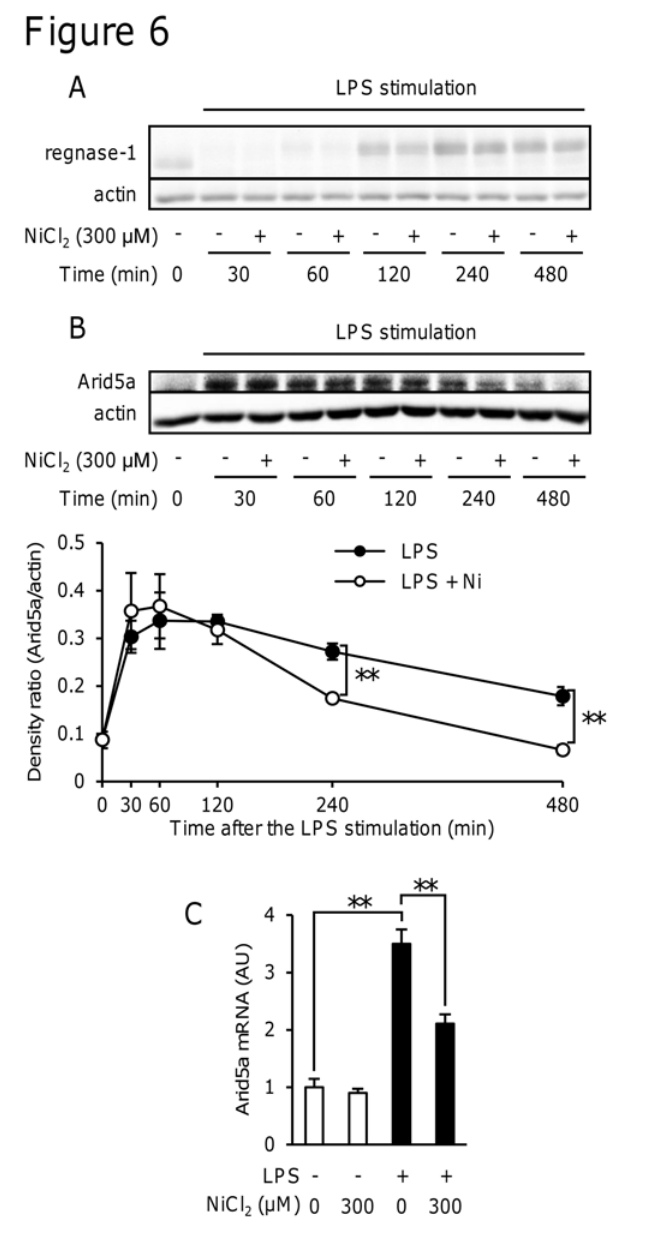
Fig 6. Effects of NiCl2 on LPS-induced changes in regnase-1 and Arid5a expression levels. RAW264 cells were incubated in medium containing LPS (1 μ g/ml) in the presence or absence of NiCl 2 (300 μ M) for the indicated periods (A and B) and 4 h (C). (A and B) Regnase-1, actin, and Arid5a protein levels in cell lysates were determined by immunoblotting. Protein levels of Arid5a and actin were quantified using ImageJ software (B). Data represent the mean ± S.E.M. (n = 4). Data are representative of three independent experiments. (D) Arid5a mRNA levels were measured by quantitative real-time PCR. Values are normalized to those of GAPDH and the mean value of the control was set to 1.0. Data represent the mean ± S.E.M. ( n = 4). ** p < 0.01 between the indicated groups. Data are representative of two independent experiments.